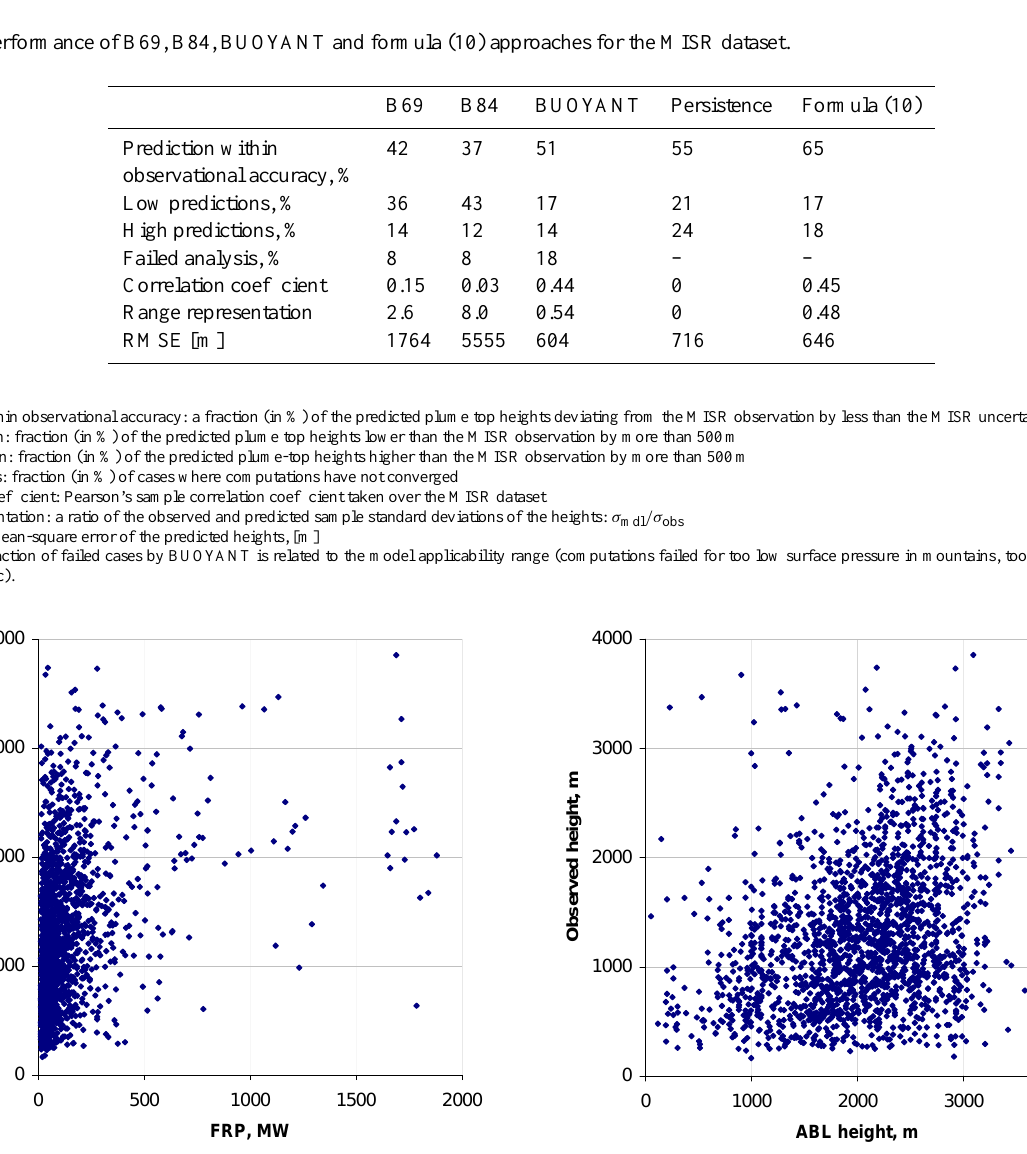
Figure 3. Correlation of the observed plume height and individual components of the formula ( 10 ): boundary layer height and FRP.